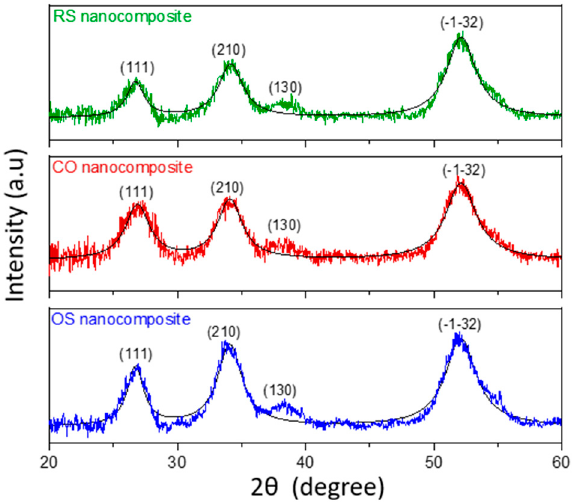
Figure 3. XRD diffractogram of OS, CO, and RS nanocomposites.